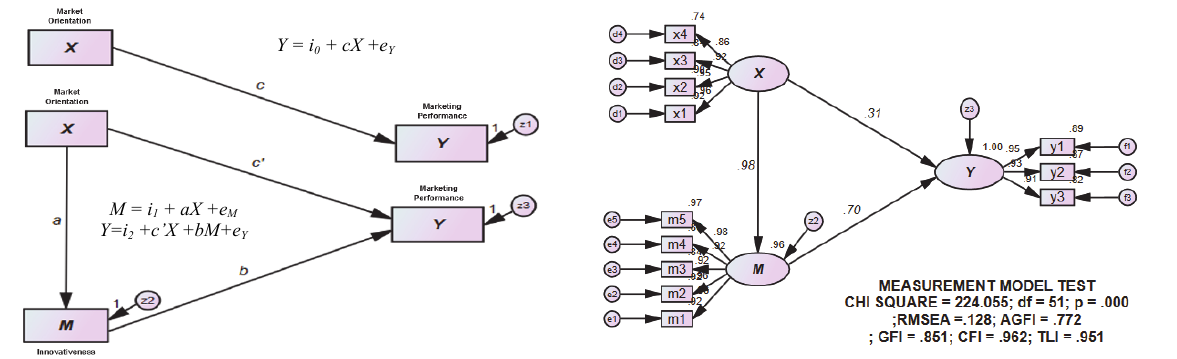
Fig. 3. Simple Mediating Models (innovativeness) Fig. 4. Analysis Model